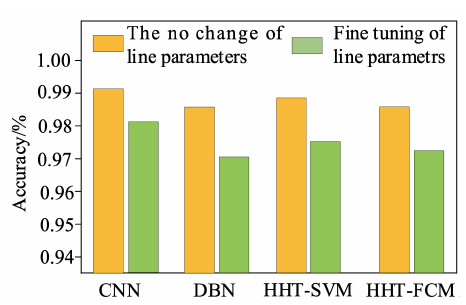
Fig. 10. Comparison of fault line selection accuracy of each model